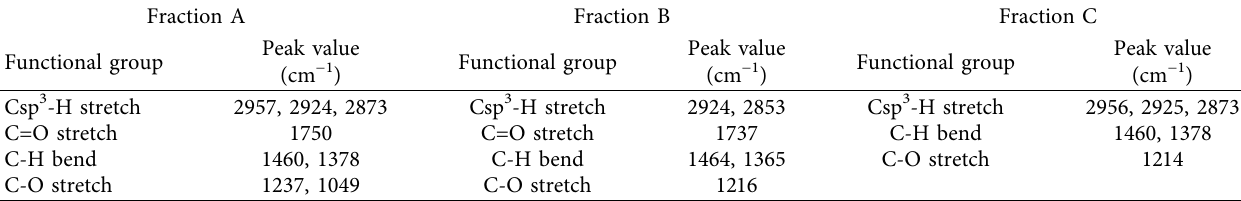
Table 12: FTIR interpretation of fractions A, B, and C from the ethanol extract of C. nioroense